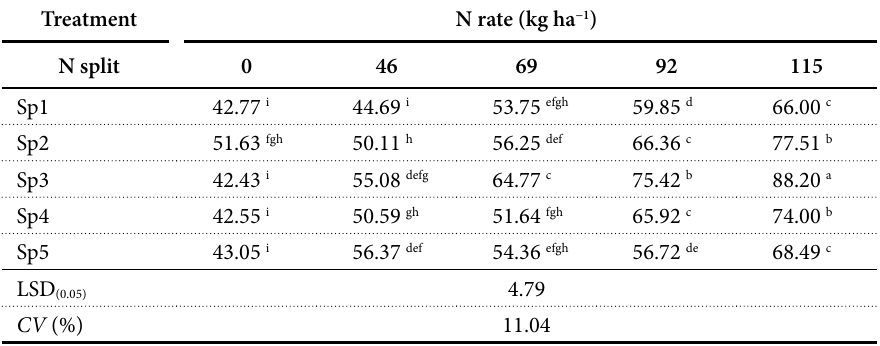
Tab. 6 Interaction effects of N rate and time of application on fresh weight of mother rhizome per plant (g plant −1 ) of Curcuma longa grown at Tepi, southwestern Ethiopia in 2016/2017.